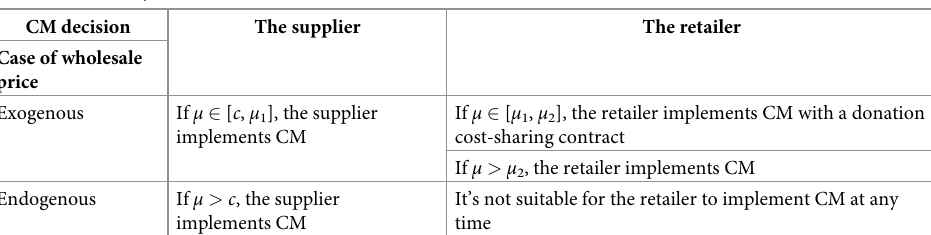
Table 2. Summary of the main